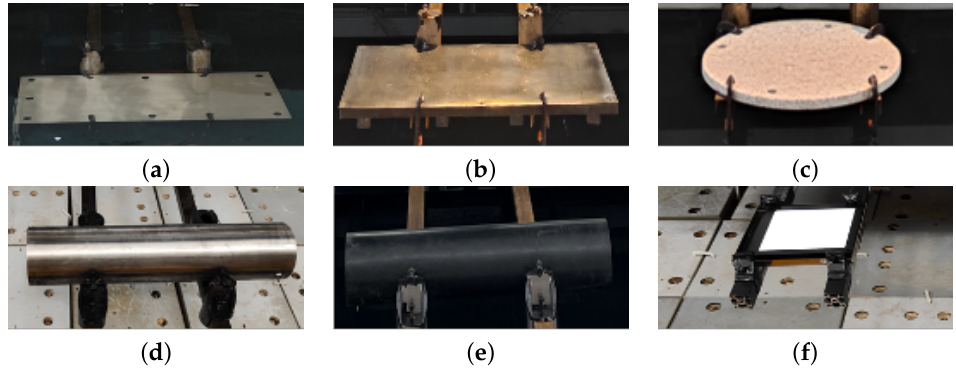
Figure 5. Photos of the targets and reference plate on the water. ( a ) Iron plate. ( b ) Rubber plate. ( c ) Stone disc. ( d ) Iron column. ( e ) Rubber column. ( f ) Reference plate. (2) Data Acquisition: In Figure 6, we used a bracket to hold the target horizontally, and the bracket was connected to a hydraulic lift rod to achieve depth variations from 0 to 3.1